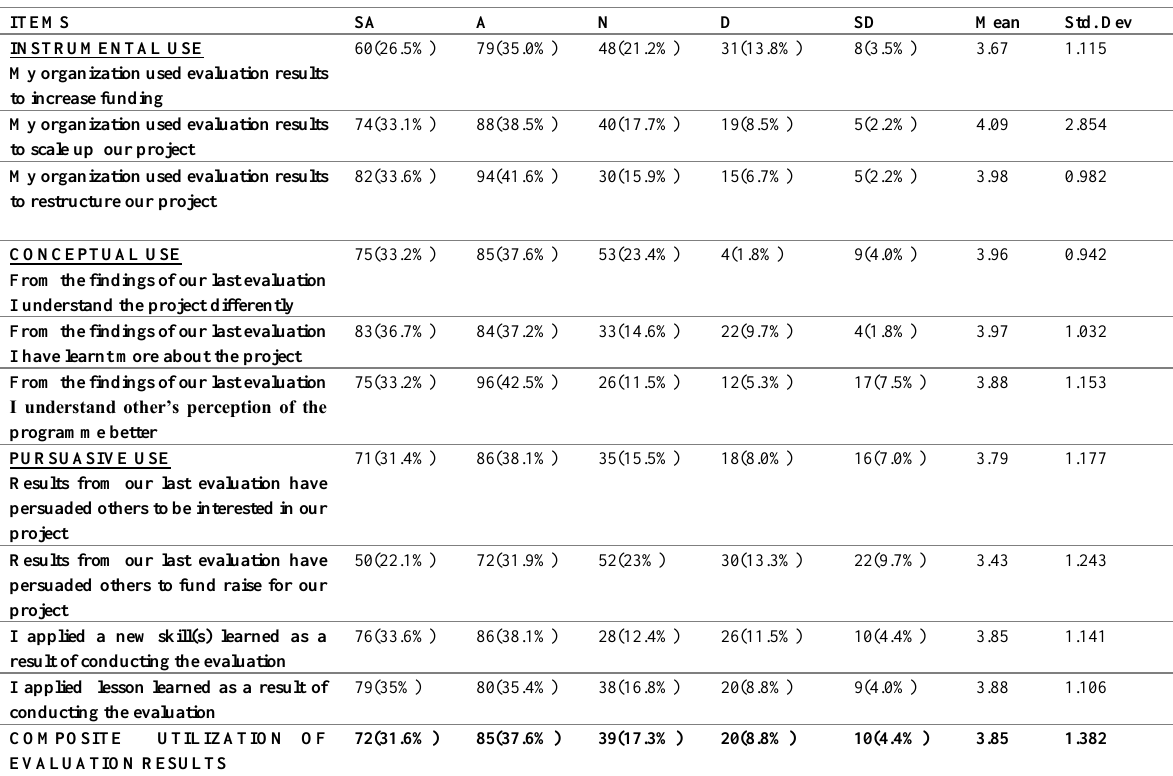
Table 2: Utilization of Evaluation